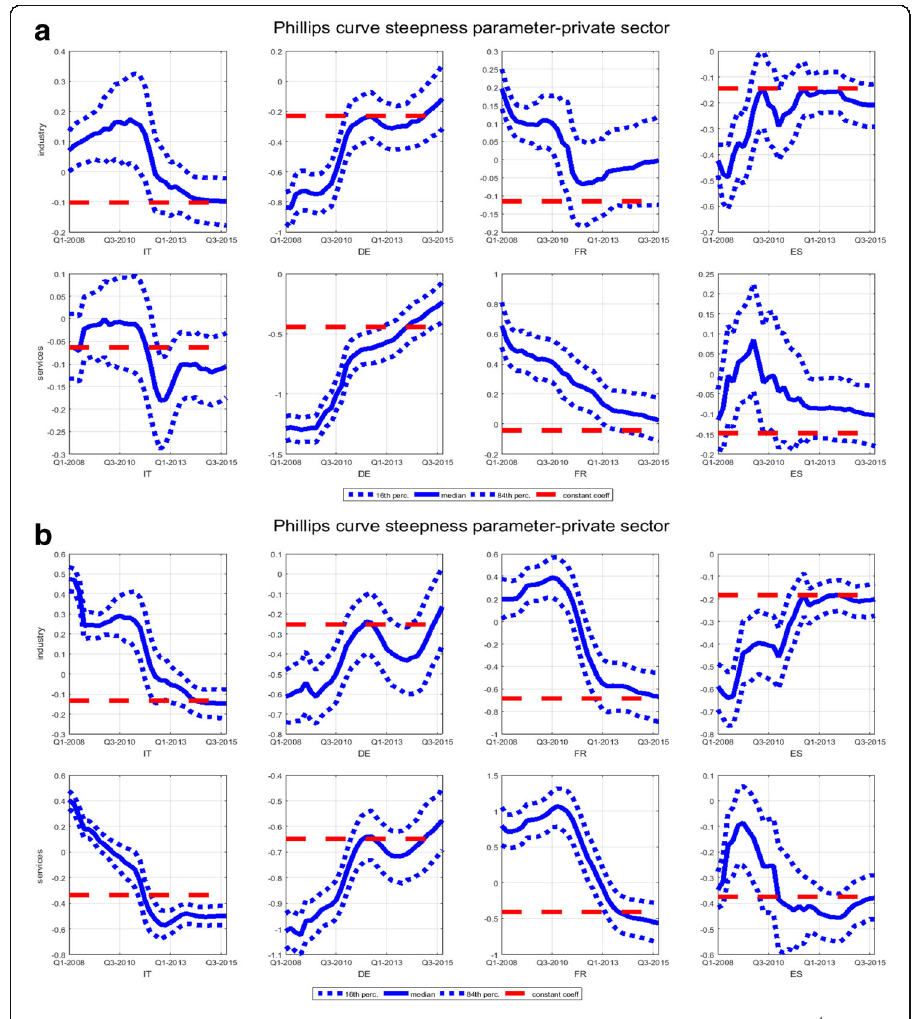
Fig. 5 Sector-specific evidence of instability of the unemployment parameter in wage Phillips curve. a Δ 4 w t ¼ c